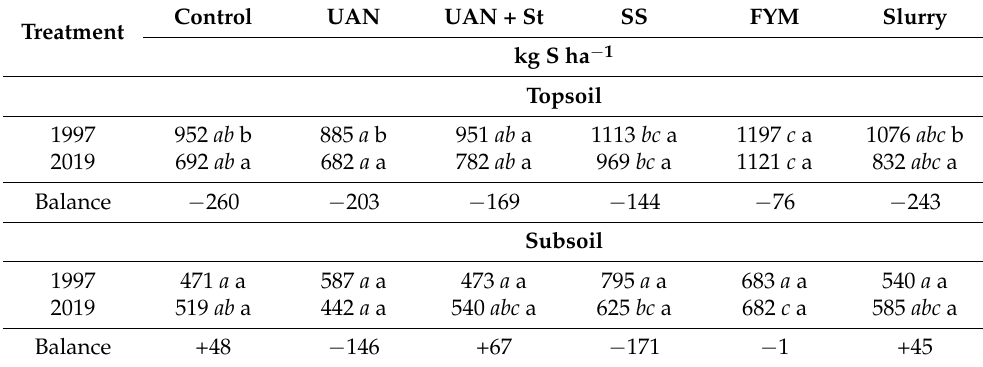
Table 11. Balance of pseudo-total sulfur in topsoil and subsoil comparing the year 1997 to 2019.